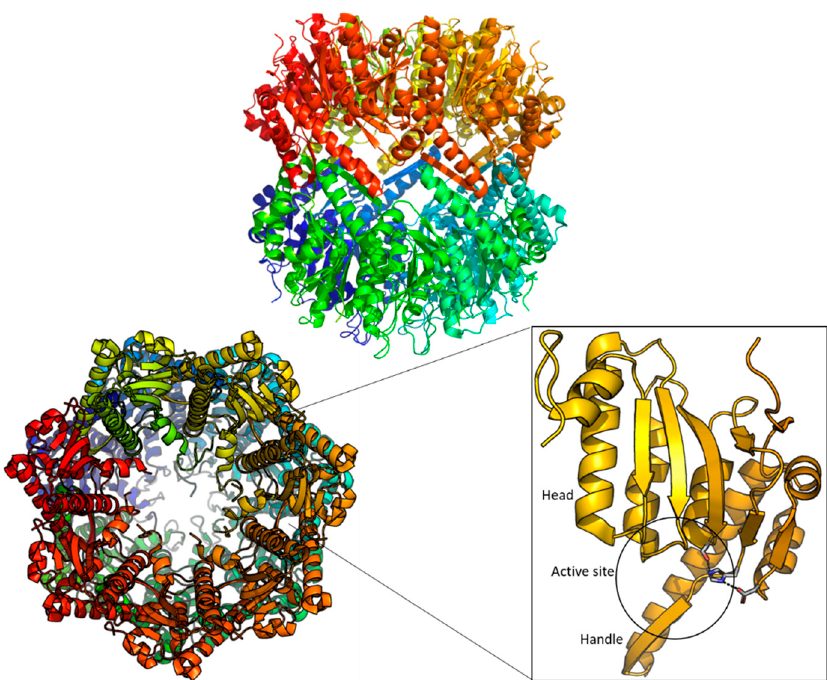
Figure 2. Structure of the full E. coli ClpP tetradecamer (top: side view, bottom left: top view) and the ClpP monomer (bottom right). Every monomer is shown in a different color in cartoon representation. The monomer is shown to emphasize the active site and the catalytic triad (S172, H122, D171) is shown in grey stick representation. (PDB ID: 1YG6).